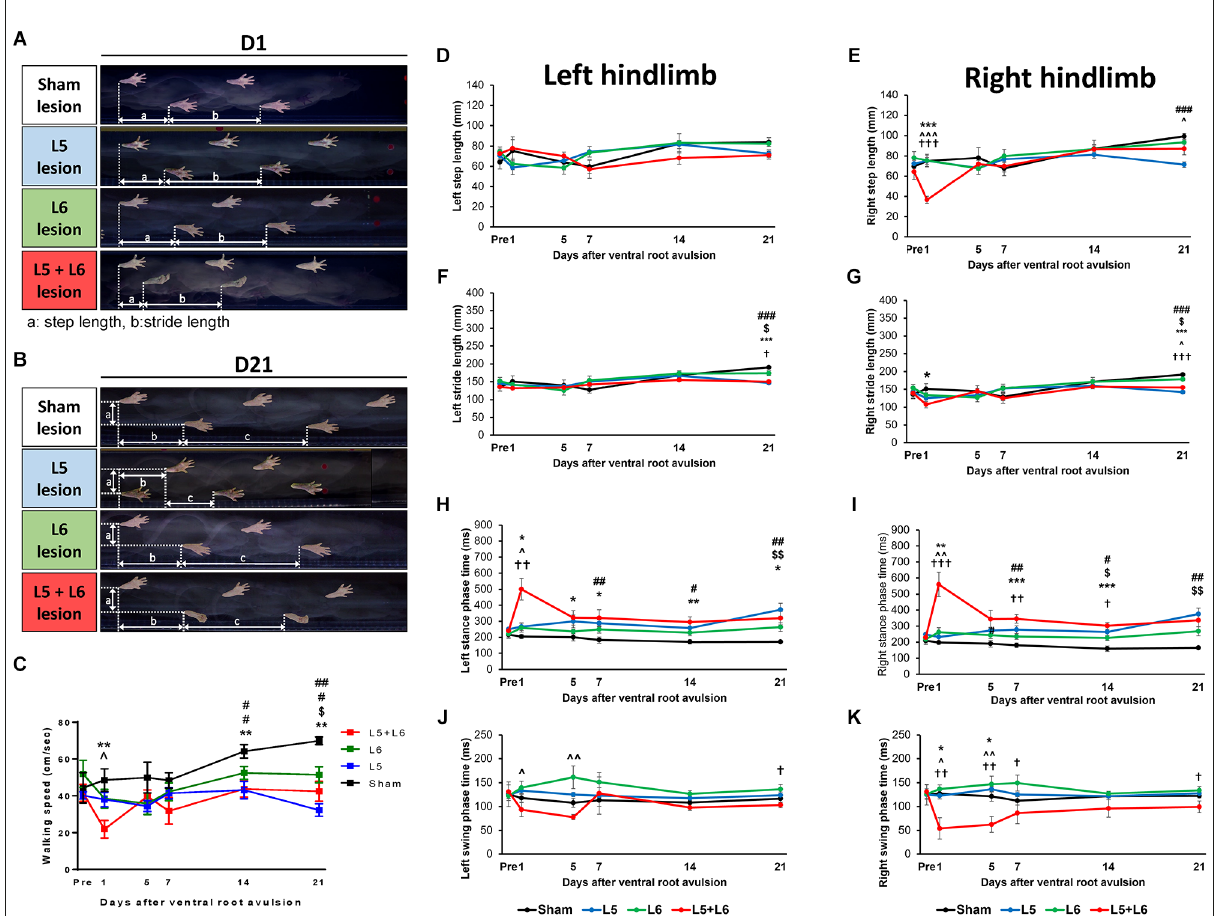
FIGURE3 Tracking of hindlimb footprints during locomotion in four different groups on Day 1 and Day 21 post-avulsion. The heels as the reference point for measuring the distance (a) step length and (b) stride length were obtained from the bottom view. Photographs of each group of stepping footprints of rats on the 1st day and 21st day post-lesion in gait analysis (A,B) . The time-course changes in the walking speed (C) and left and right step and stride length of four groups over 21 days of observation (D–G) . The time-course changes in the stance phase and swing phase duration in the left and right hindlimb (H–K) . Note that the footprints in L5 + L6 ventral root avulsion rats clearly showed smaller step lengths, especially on the right (affected) side, however, the sham group rats displayed a comparatively consistent step length. * p < 0.05, ** p < 0.01, *** p < 0.001 significant differences are shown between the sham and L5 + L6 groups. ∧ p < 0.05, ∧∧ p < 0.01, ∧∧∧ p < 0.001 indicate significant post hoc Fisher’s LSD differences when compared between L5 lesions and L5 + L6 lesions. † p < 0.05, †† p < 0.01, ††† p < 0.001 indicate significant post hoc differences between the L6 lesion and the L5 + L6 lesion groups. $ p < 0.05, $$ p < 0.01, indicates significant post hoc Fisher’s LSD differenceswhen comparedbetween theshamlesion groupandL6 ventralroot avulsion. # p < 0.05, ## p < 0.01, ### p < 0.001indicate significant post-hoc differences when compared between the sham lesion group and L5 ventral root